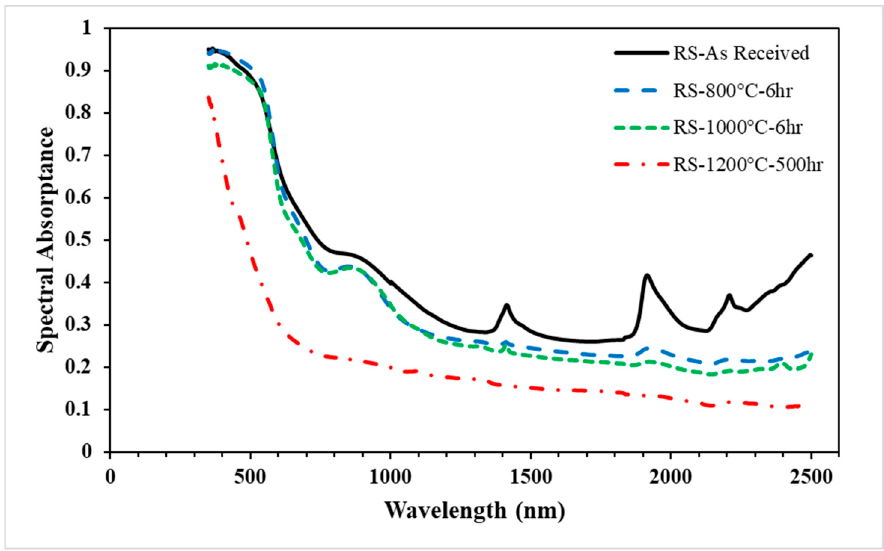
Figure 4. Spectral absorptance of the red sand samples (“as received” and after the aging test) over the wavelength.